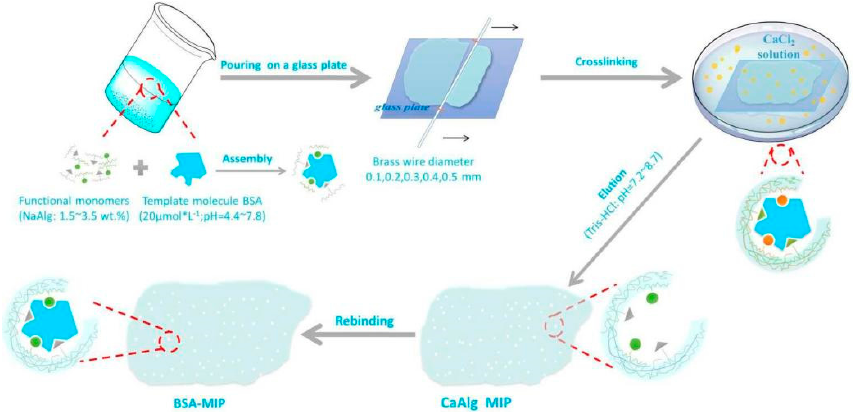
Figure 1. The schematic diagram of preparation of bovine serum albumin (BSA)-imprinted calcium alginate (CaAlg) hydrogel membrane.